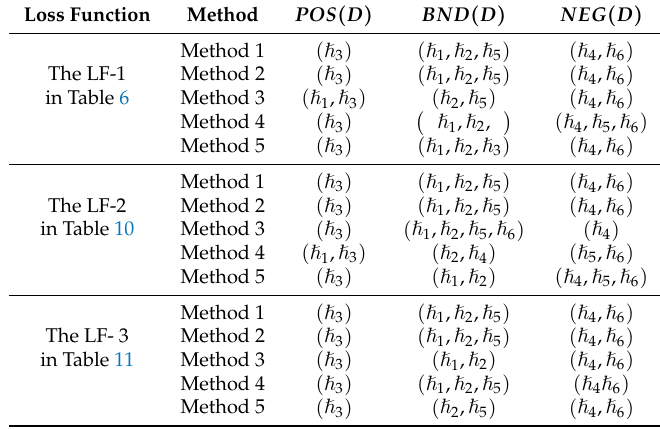
Table 12. Comparison of decision results of five methods (LF = loss